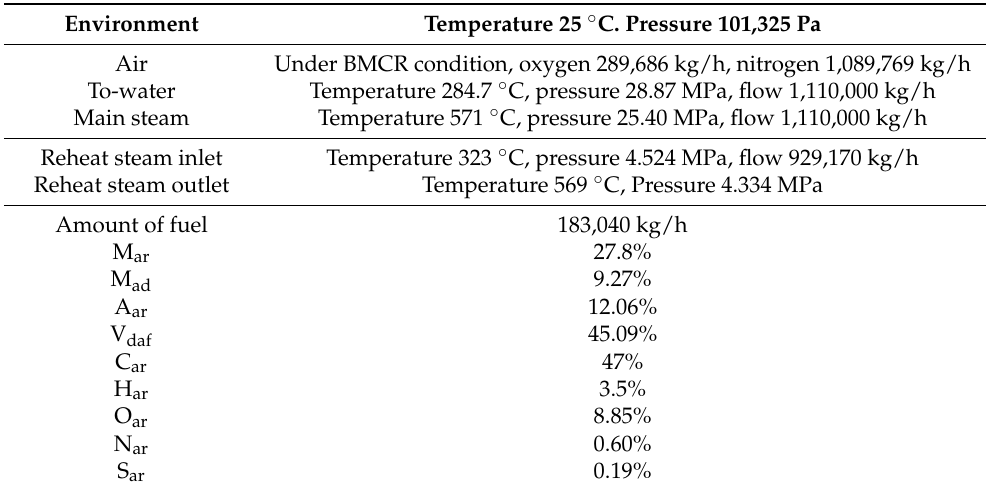
Table 5. Input parameter settings of model.